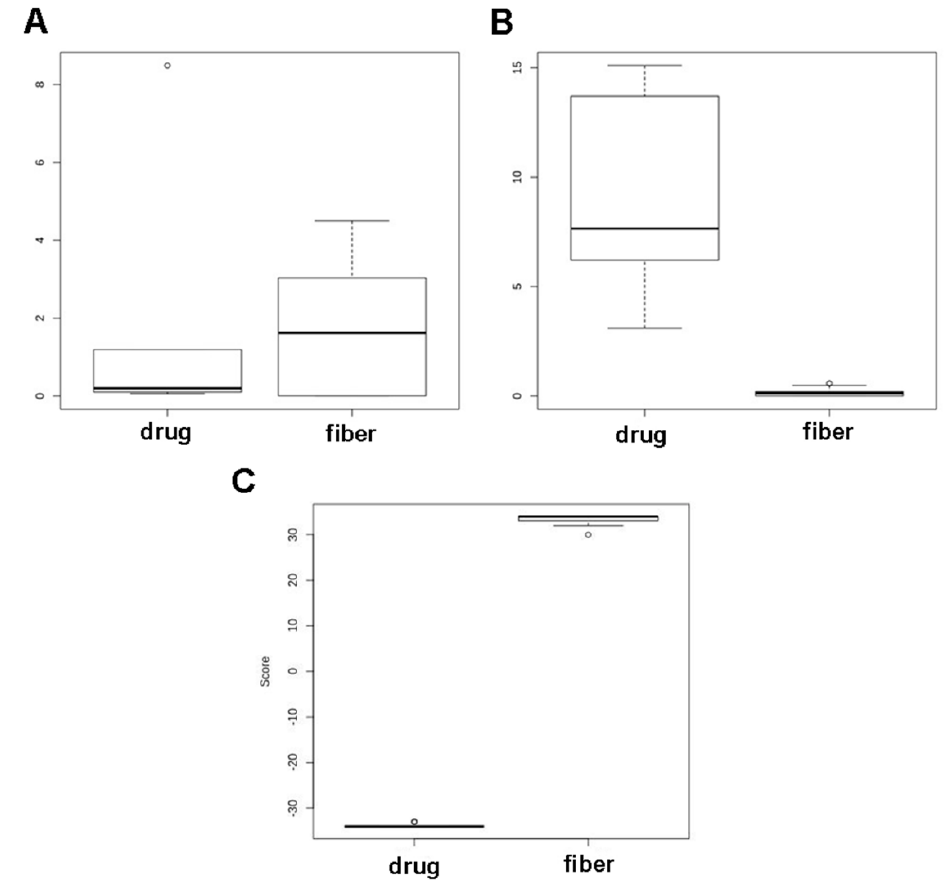
Figure 5. Box plot showing: CBD % ( A) and THC % ( B ) for the drug-type and fiber-type plants based on the SNPs and deletions identified; score ( C ).